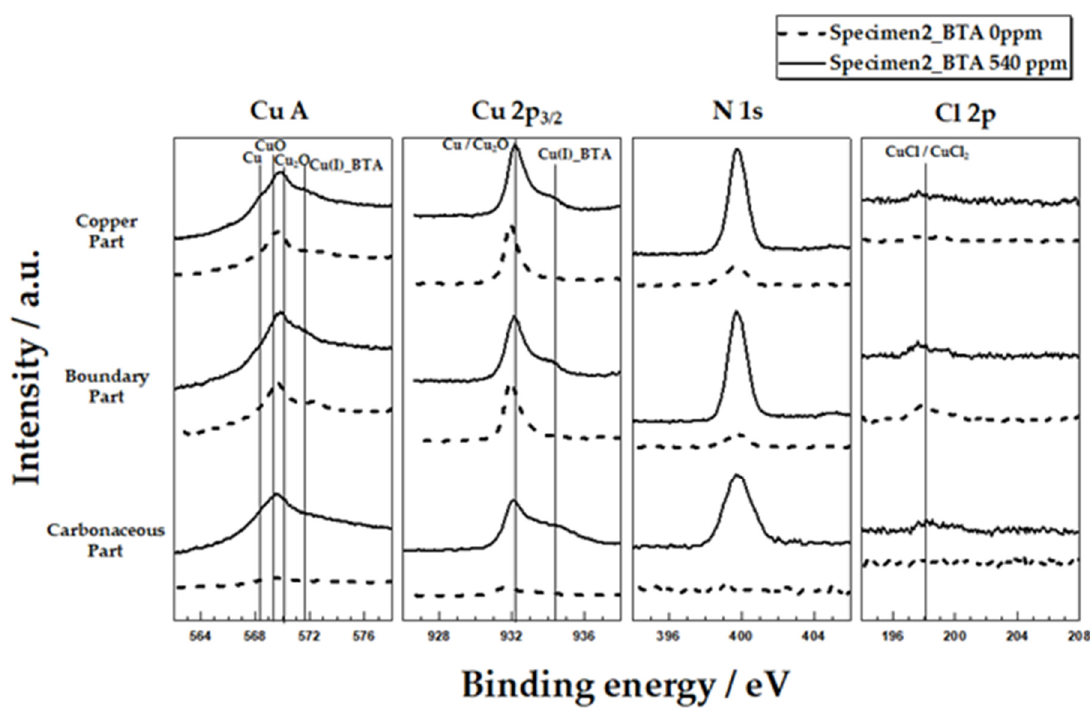
Figure 4. Cu LMM X-ray induced spectra and Cu 2p3/2, N 1s, and Cl 2p XPS spectra recorded at the surface of copper after 24-hour immersion in synthetic tap water at 25 ◦ C based on the presence and absence of